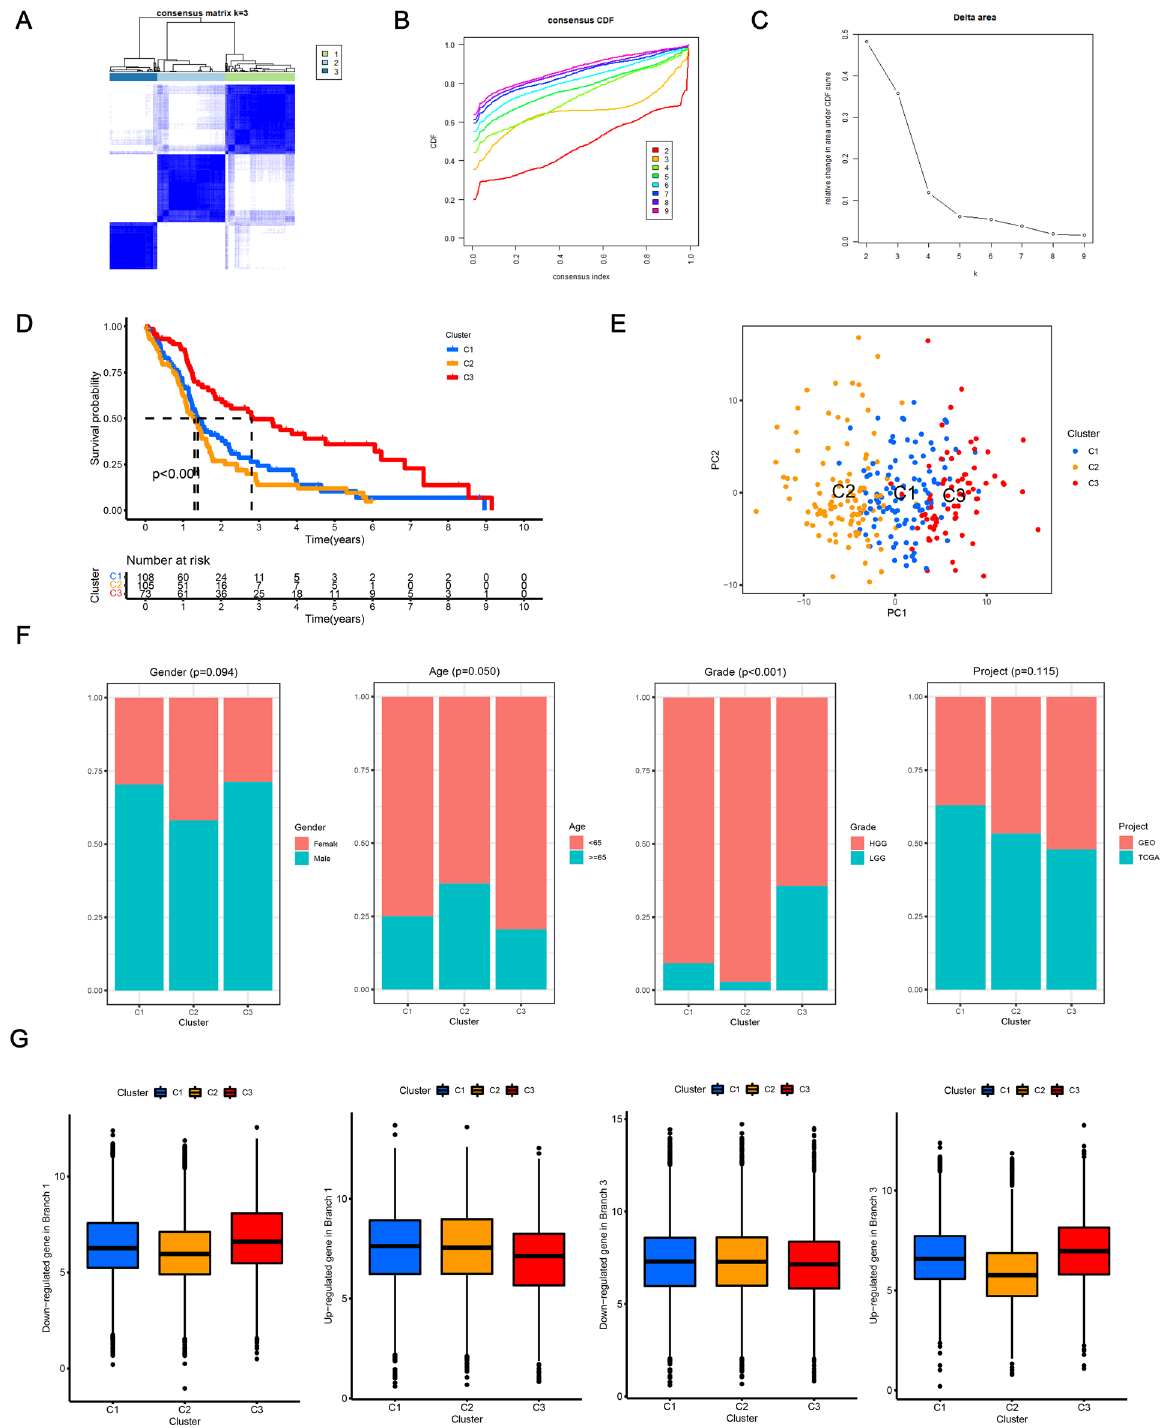
Figure 2. Classification for glioma patients based on DRGs. ( A – C ) The results of consensus clustering analysis for glioma patients based on DRGs. ( D ) Overall survival analysis between patients in the three clusters. ( E ) Scatter plot demonstrating the result of PCA for the classification of glioma patients based on DRGs. ( F ) Comparisons of clinicopathological features across the three clusters. ( G ) The up/down-regulated DRGs in differentiation state 1 and 3 showed similar expression patterns in C2 and C3 clusters, respectively. DRGs: differentiation related genes, PCA: principal component